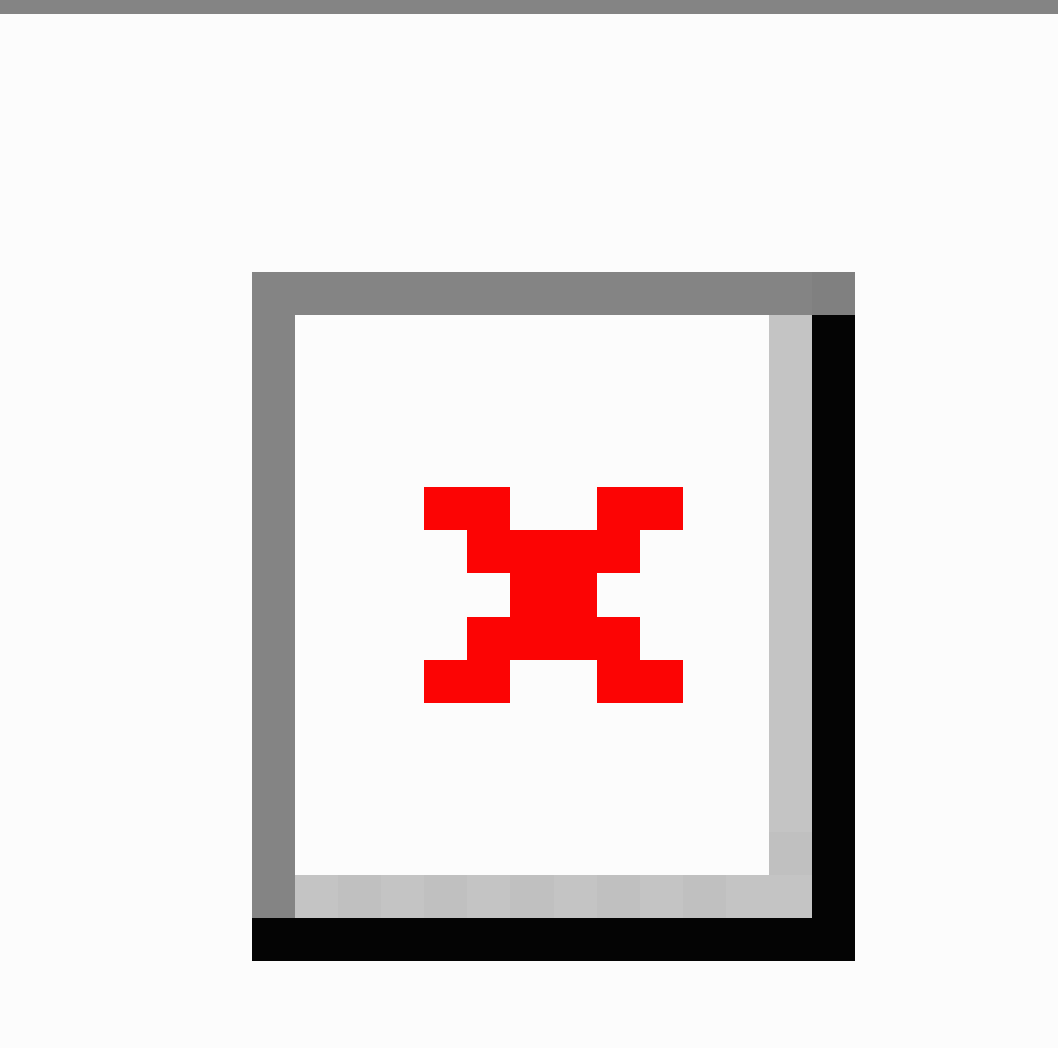
Figure 2. Fun without Smokes study flowchart of baseline (T0), 12-month follow-up (T1), and 25-month follow-up (T2) measurement